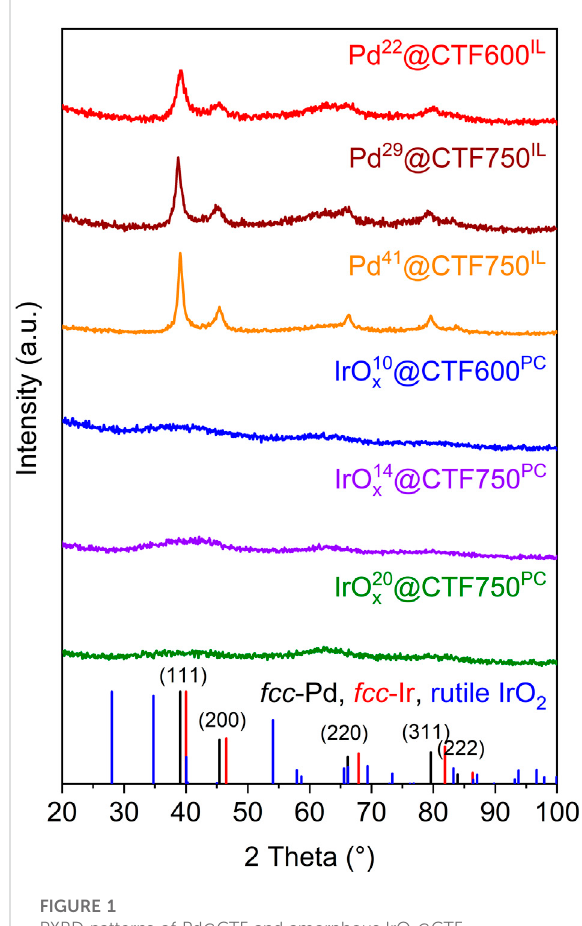
FIGURE 1 PXRD patterns of Pd@CTF and amorphous IrO x